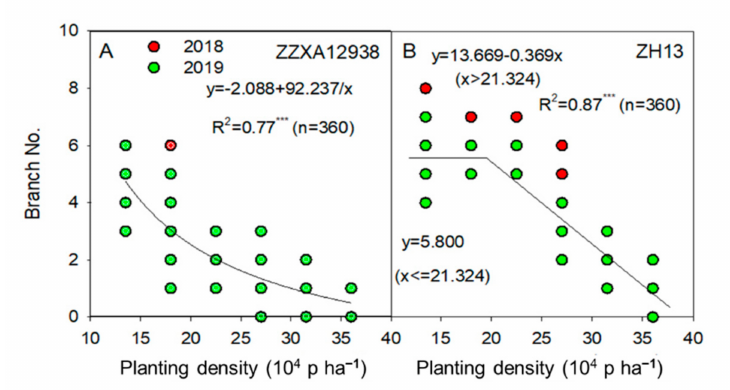
Figure 5. The relationship between the number of branches and soybean planting density for ( A ) ZZXA12938 and ( B ) ZH13. Markers with different colors represent different growing season; *** indicates that the correlation is significant at the p ≤ 0.001 level.